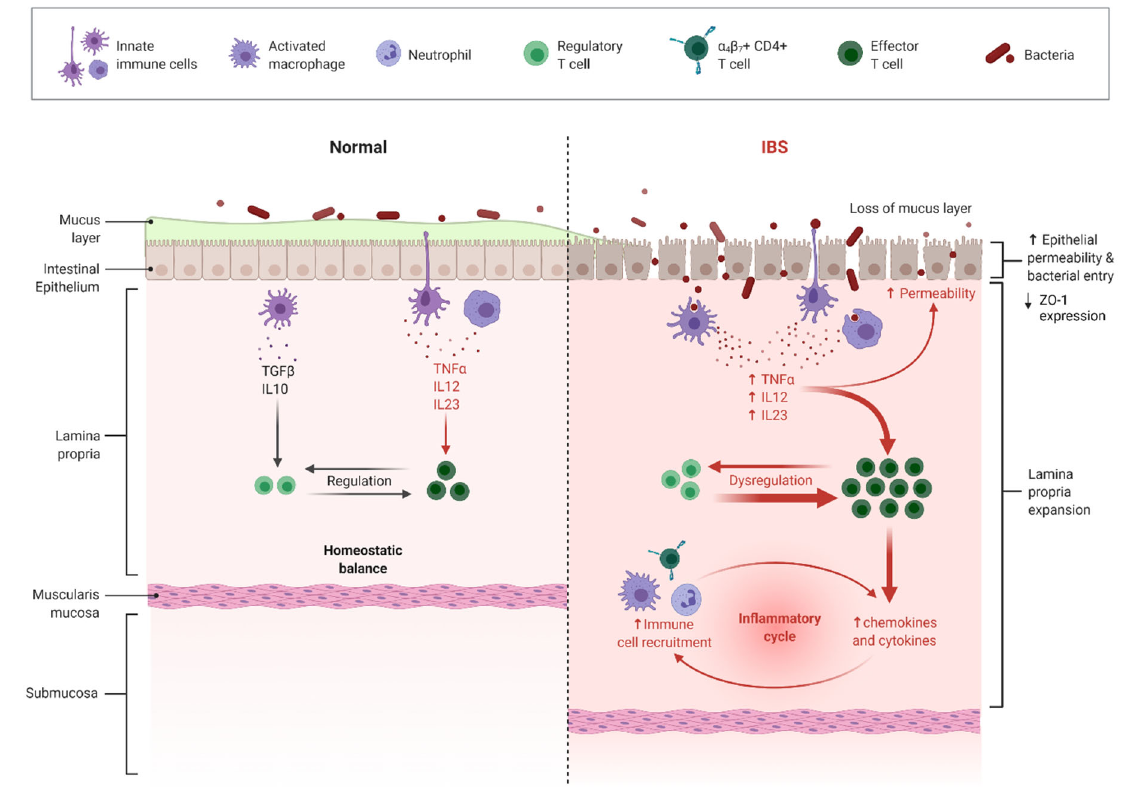
Figure 2. Intestinal epithelium in healthy and IBS patients. Figure 2 was created using BioRender, Toronto, Canada, Subscription agreement number: TU237PZA2O for Microorganisms .